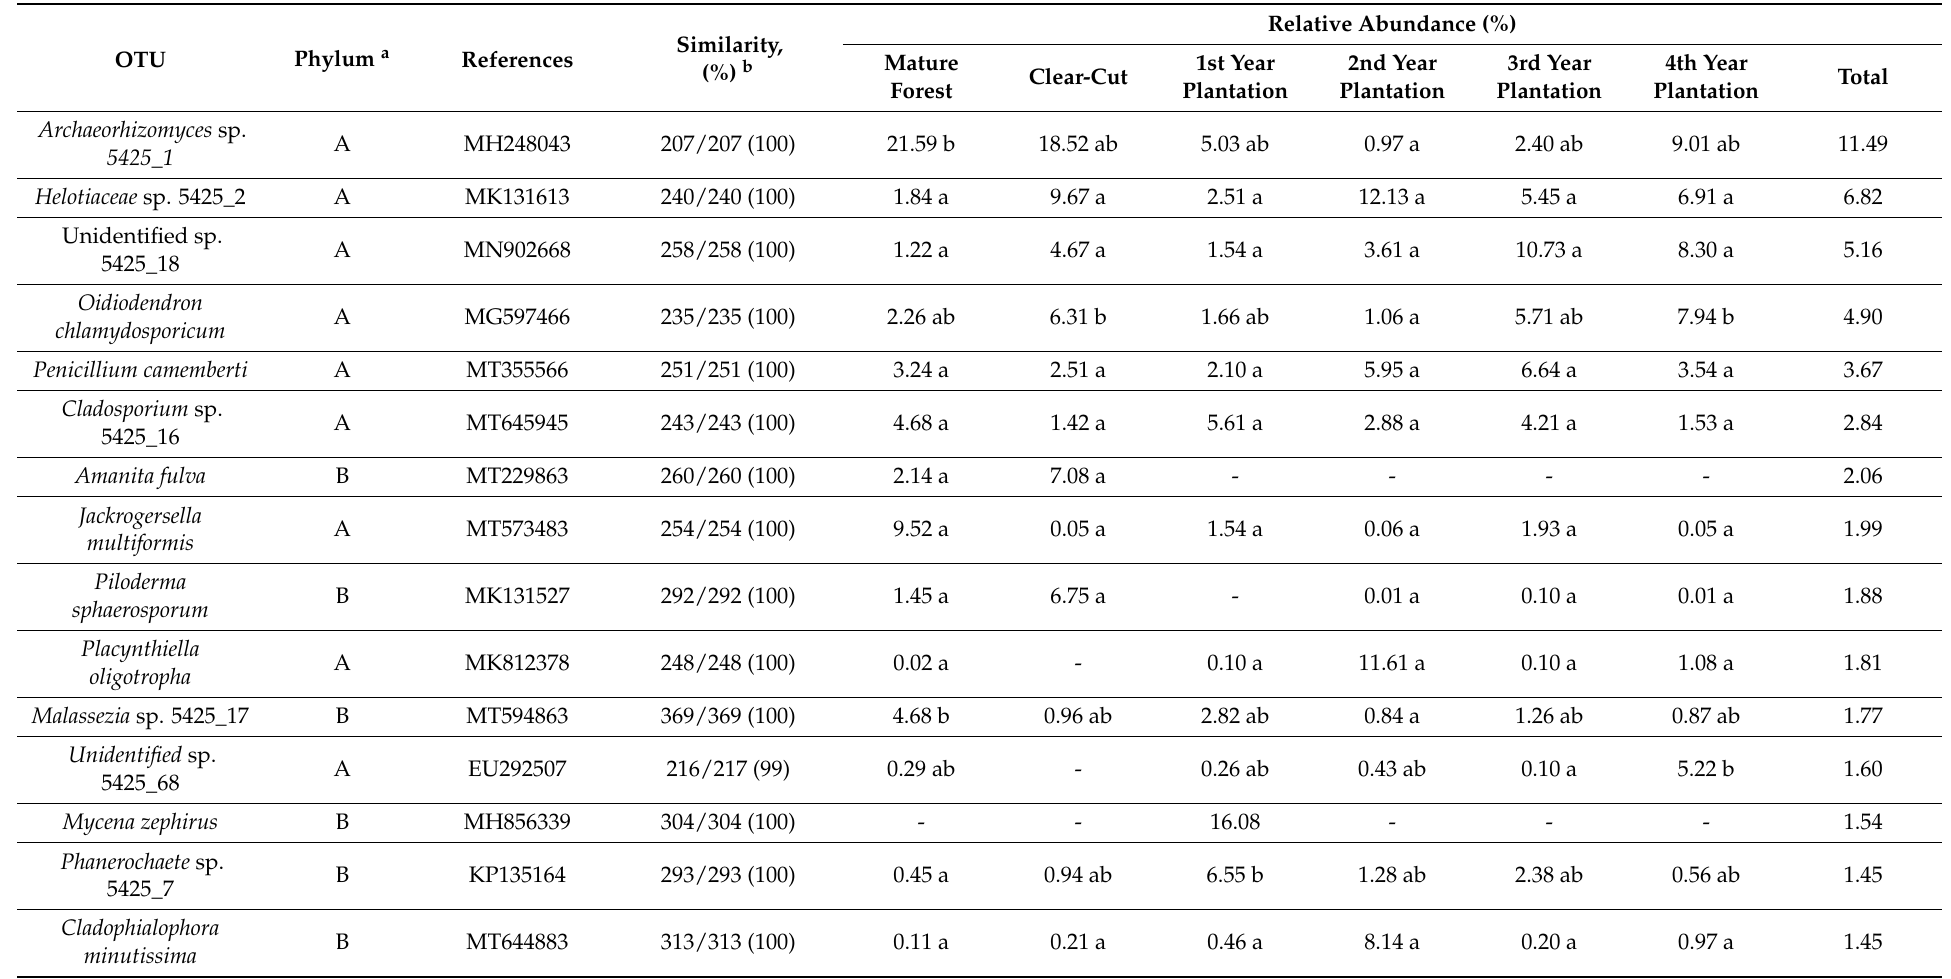
Table 4. Relative abundance and similarity of the 30 most common fungal OTUs (shown as a proportion of all the high-quality fungal sequences) in the soil samples from the Pinus sylvestris L. sites, representing mature forests, clear-cuts, and reforested 1st–4th year plantations; the data from three study sites (A, L, and V) were combined. The values followed by different letters within each row indicate statistically significant differences at p <